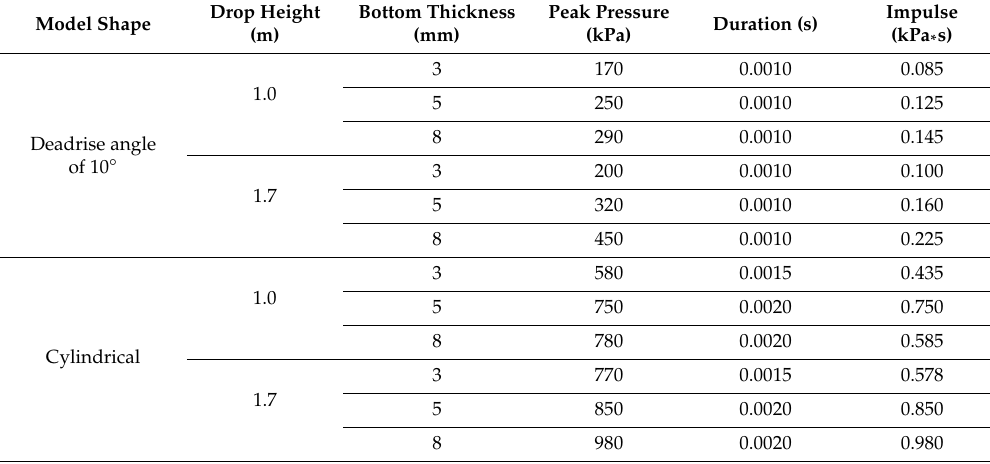
Table 8. Peak pressure, duration, and impulse for the cylindrical model and model with deadrise angle of 10 ◦ at first peak